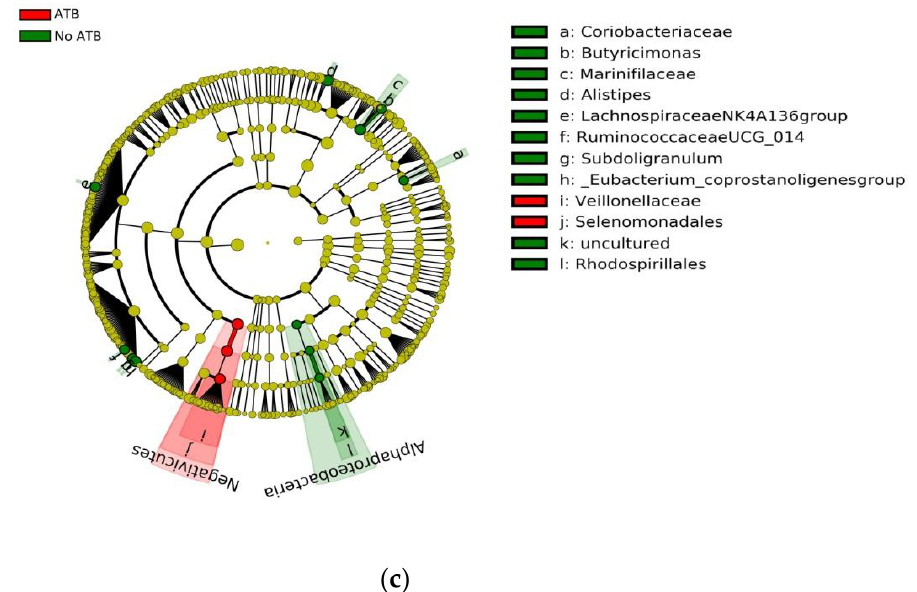
Figure 2. Gut microbiota composition and ATB usage. ( a ) Chao 1 index score of the gut microbiota in patients stratified according to ATB usage, by the Mann–Whitney U rank sum test. Error bars represent the distribution of alpha-diversity scores. ( b ) Multi-level differential abundance analysis using linear discriminant analysis (LDA) effect size (LEfSe) of patients stratified according to ATB usage. ( c ) Taxonomic cladogram from the LEfSe analysis showing differences in fecal taxa in ATB and non-ATB groups. Dot size is proportional to the abundance of the taxon. Green legends represent patients who did not receive ATB treatment, and red legends the patients who were prescribed ATB within 3 months before ICB treatment. ATB: antibiotics. LDA score > 3.0; p < 0.05.